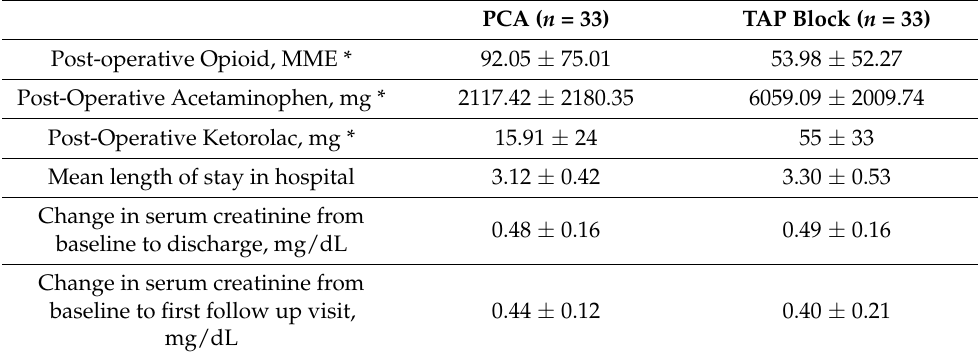
Table 2. Pain management and renal function